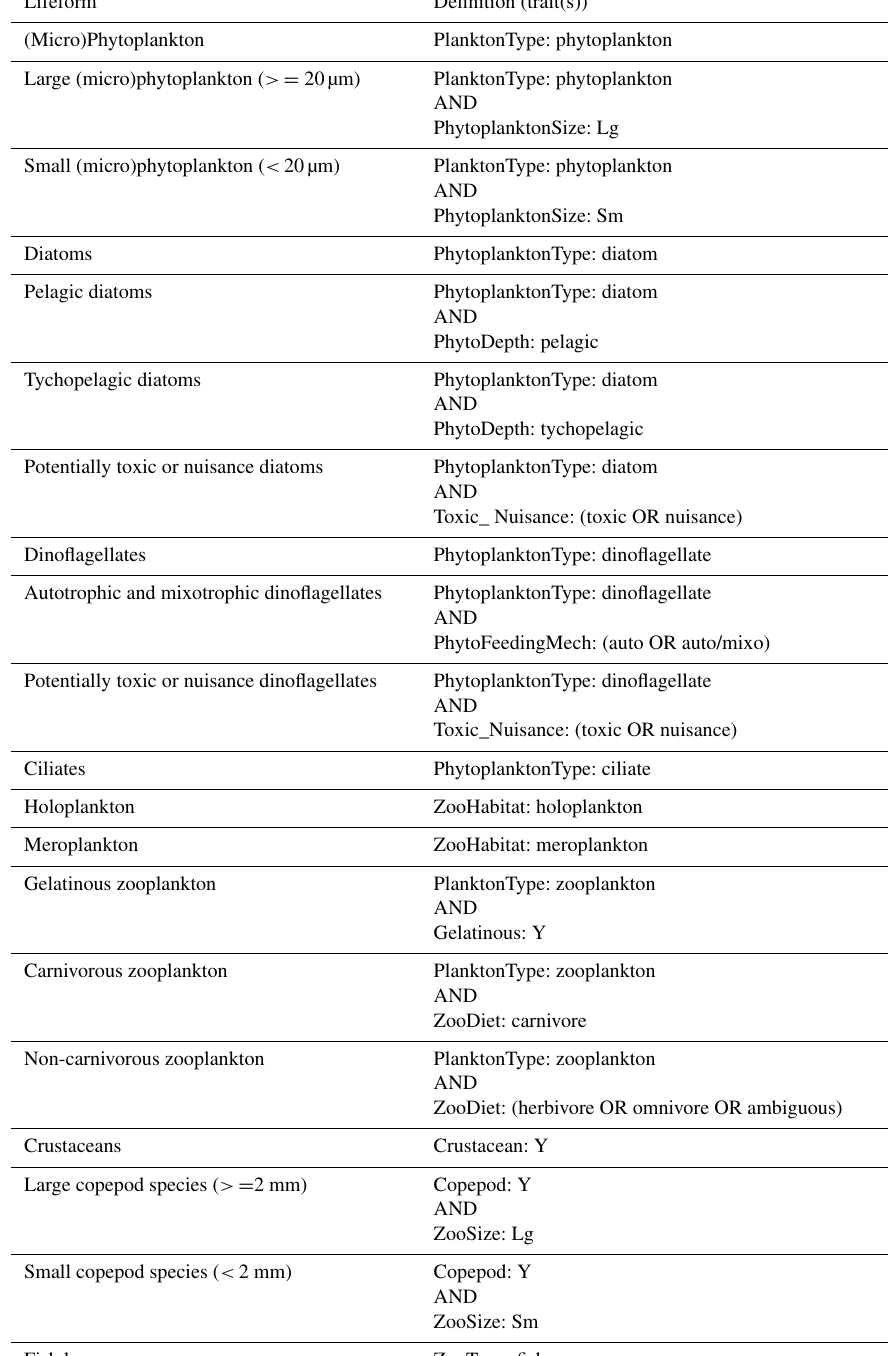
Table B1. Definitions of lifeforms by trait as defined in the trait list. See Table 2 for descriptions of traits